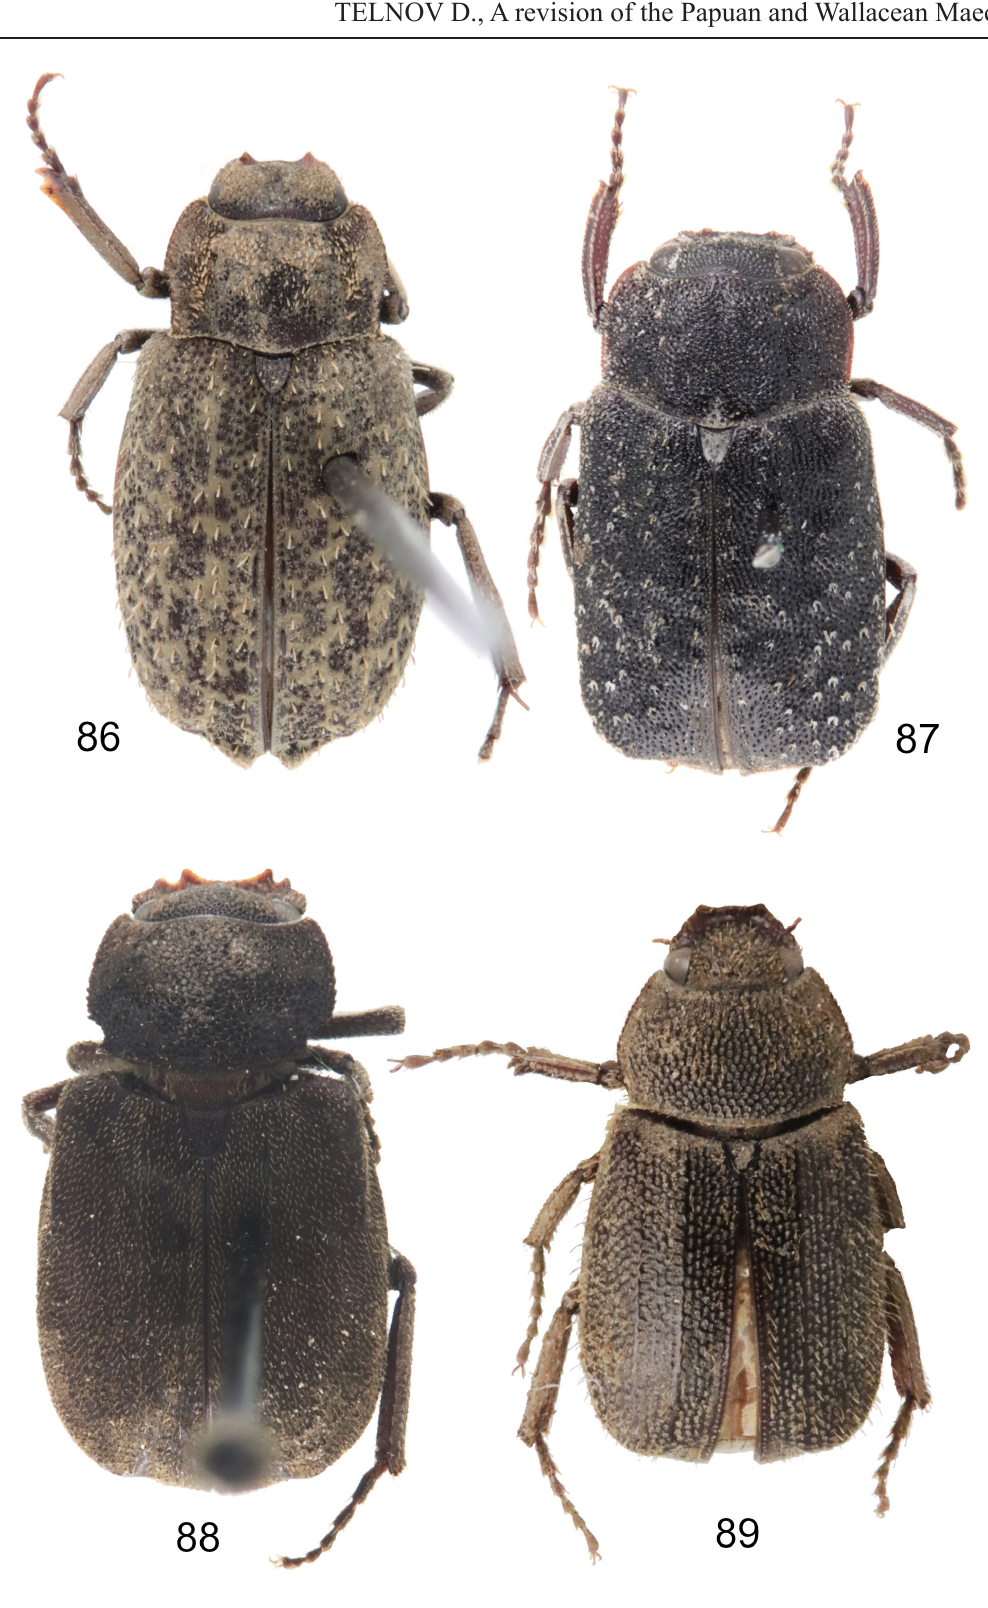
Figs 86–89. Papuan and Wallacean Maechidius Macleay, 1819, habitus, dorsal view. 86 . M. speciosus (Frey, 1969) comb. nov., ♀ (BMNH). 87 . M. sturnus Arrow, 1941, holotype, ♂ (BMNH). 88 . M. subcostatus Heller, 1895, lectotype, ♂ (SNSD). 89 . M. suwawa sp. nov., holotype, ♂ (BMNH). Not to